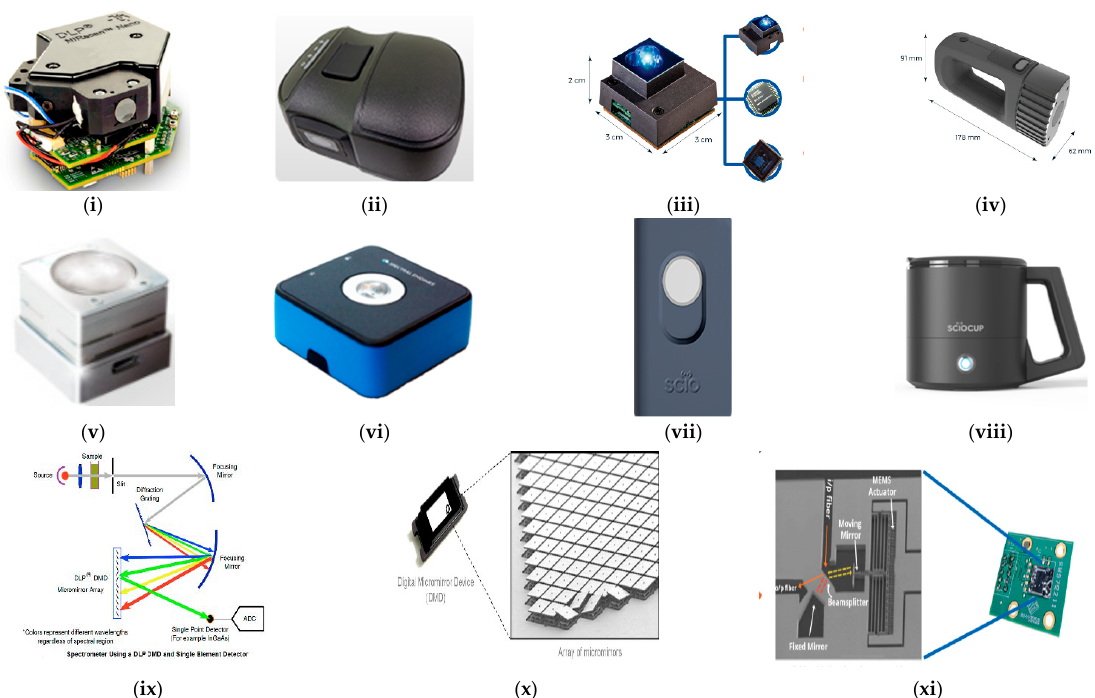
Figure 4. Commercially available handheld NIR devices. ( i ) DLP, the NIR Scan TM Nano optical engine [55] ; ( ii ) The NIR-S-G1 sensor based on DLP technology [56] ; ( iii ) NeoSpectra Micro monolithic MEMS Michelson Interferometer; and ( iv ) NeoSpectra Scanner [57] ; ( v ) NIRONE sensor and ( vi NIRONE device (which contains the NIRONE sensor) [58] ; ( vii ) SCiO spectrometer and ( viii ) SCiO cup [59] ; ( ix ) Spectrometer using a DLP DMD and single element detector; and ( x ) DLP DMD with a close-up of mirror array [54] ; ( xi ) Michelson interferometer on a MEMS chip [60] .(All images in Figure 4 are originally from the above cited papers, copyright permission has been granted. Courtesy Texas Instruments for Figure 4(i), (ix), (x) and (xi)).